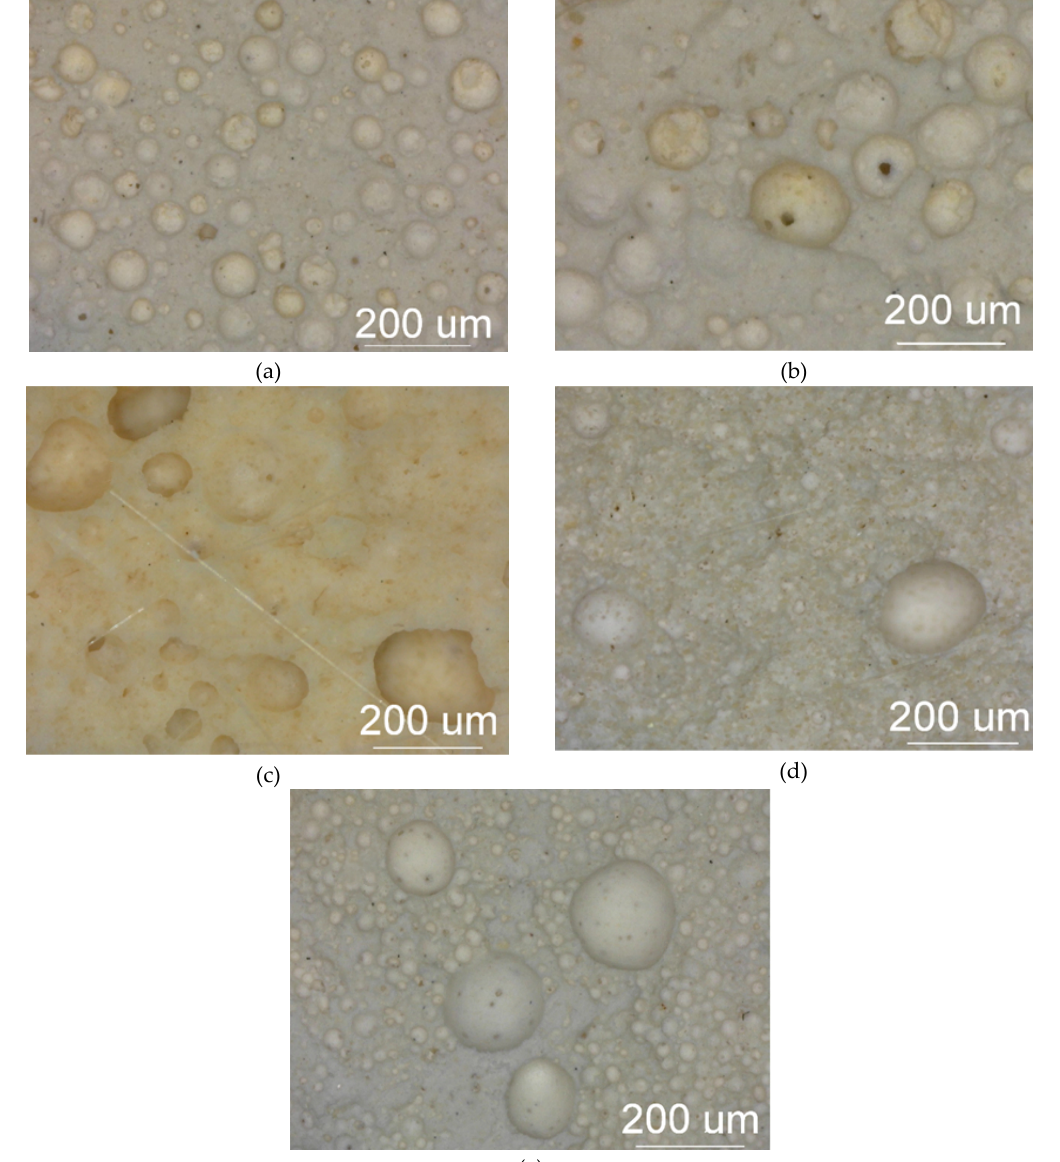
Figure 4. Macrostructure images of investigated specimen types: ( a ) type A, ( b ) type B, ( c ) type G, ( d ) type I, ( e ) type K.